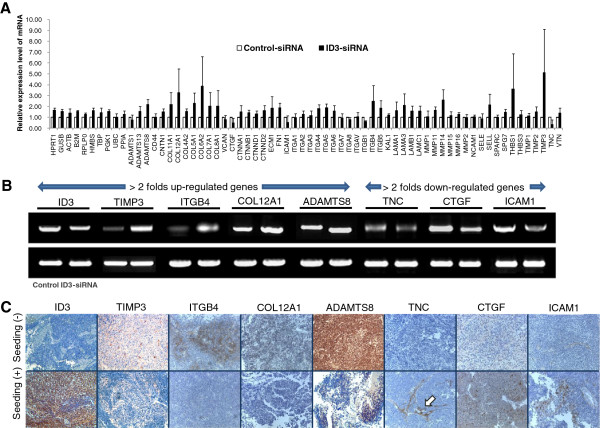
mRNA mini-array to uncover ID3-related genes. (A) Expression of 66 genes related to cellular invasion and metastasis after ID3 knockdown using siRNA in D283 cells. (B) RT-PCR of ID3 and the 7 genes with considerable initial expression levels and expression level changes of greater than 2-fold. (C) Representative images of immunohistochemistry of ID3 and 7 proteins in seeding-negative and seeding- positive medulloblastomas (200×). Note that TNC is mainly expressed in the tumor stroma (arrow) than tumor cell clusters where ID3 immunoreactivity is observed.